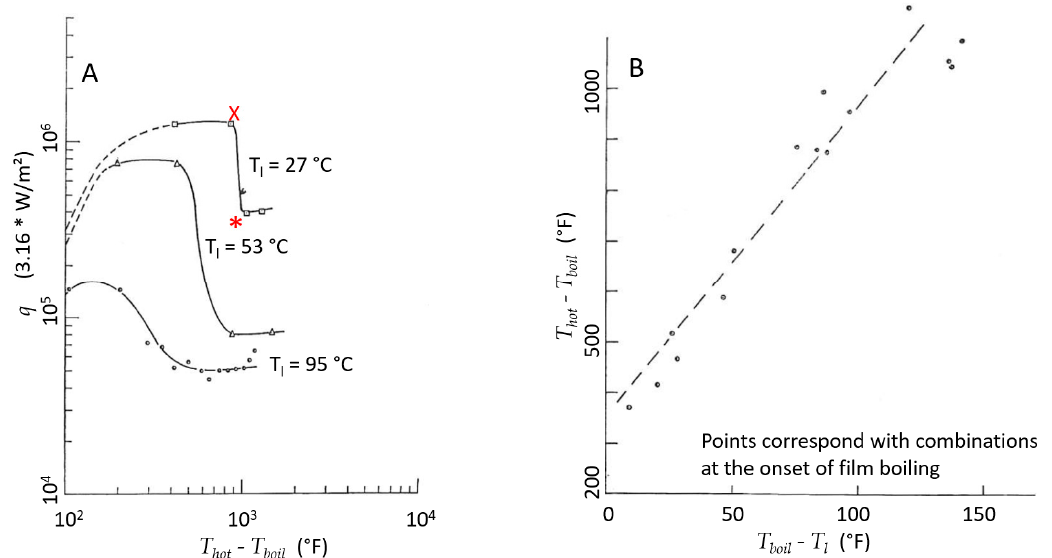
Figure 10. Dependency of boiling curve on subcooling of liquid (adapted from Reference [80]): ( A ): the ratio of heat flux and surface area (q/A) versus hot phase temperature ( T hot ) for different values of coolant temperature ( T l ); ( B ): ( T hot − T boil ) versus ( T boil − T l ) at the onset of film boiling (where T boil is the boiling temperature).